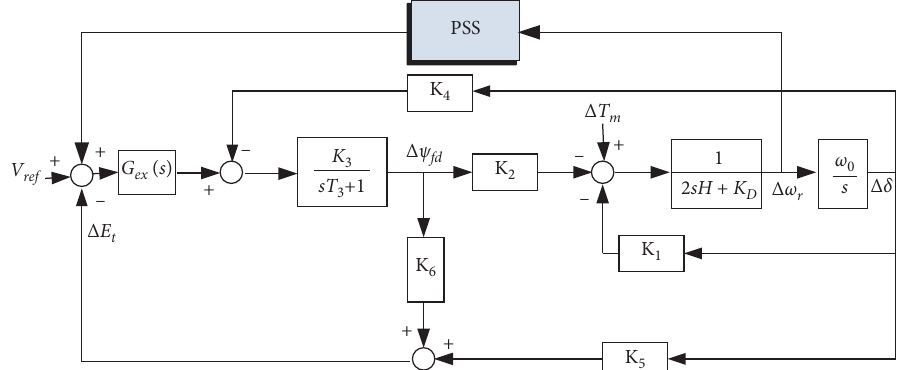
Figure 1: Hefron-Phillips model of the study SMIB system.